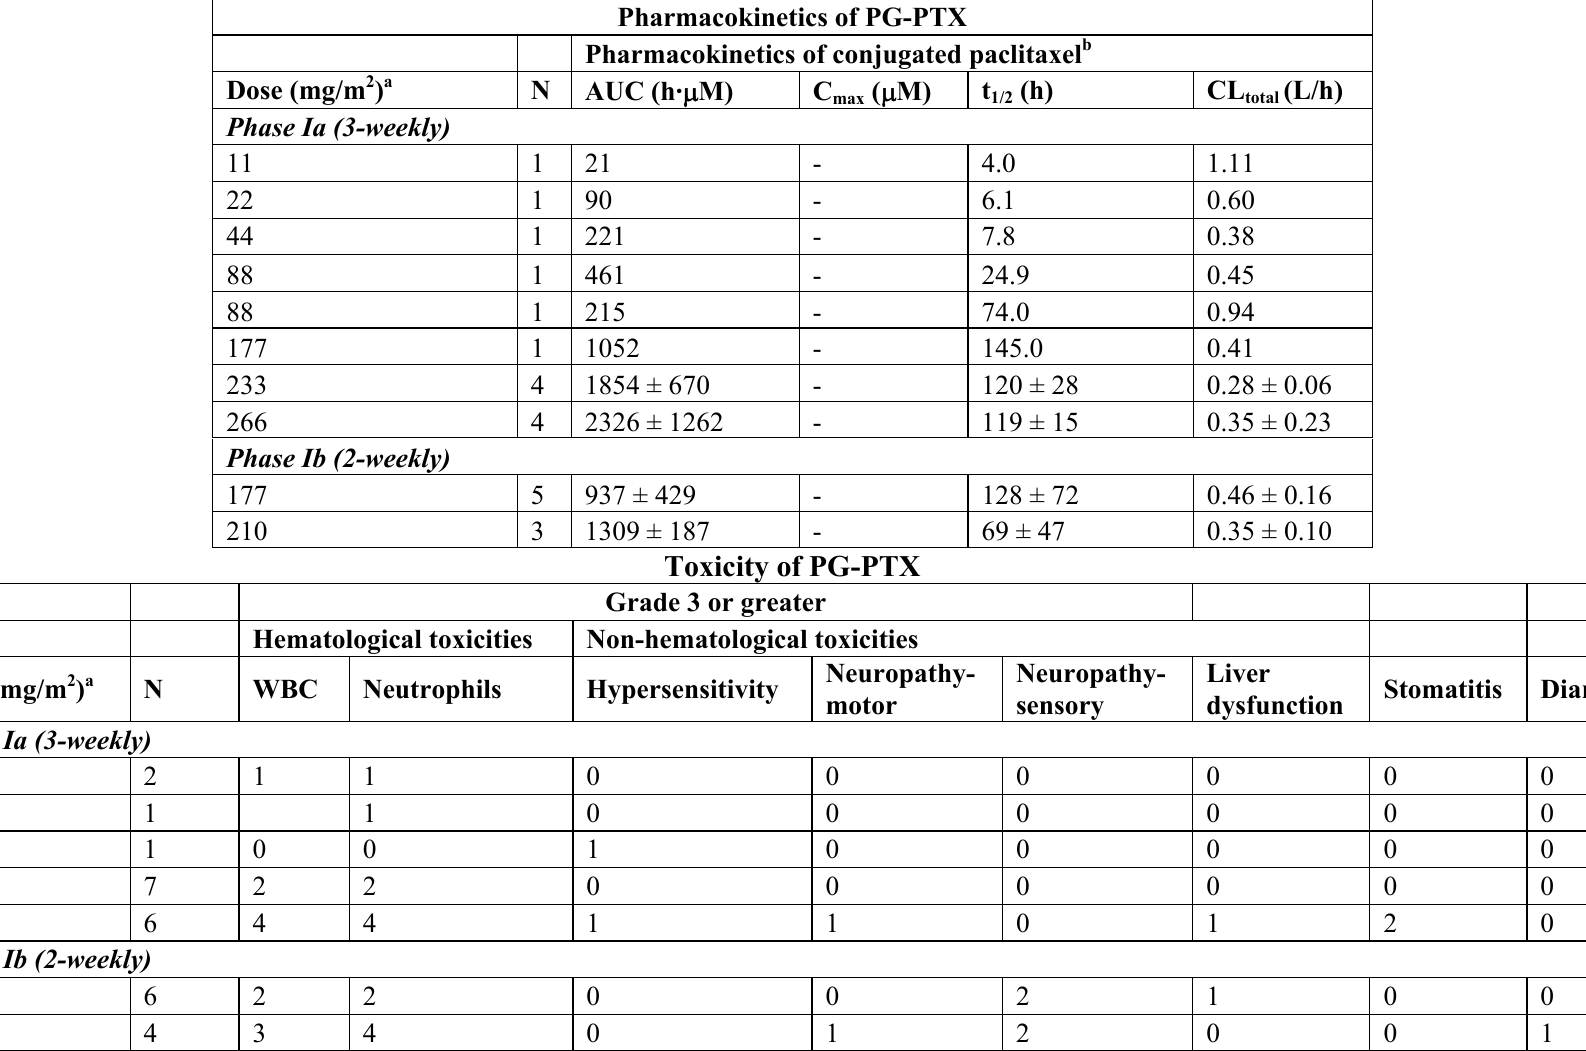
Table 7. Results of Phase I pharmacokinetic study and toxicity of PG-PTX in cancer patients